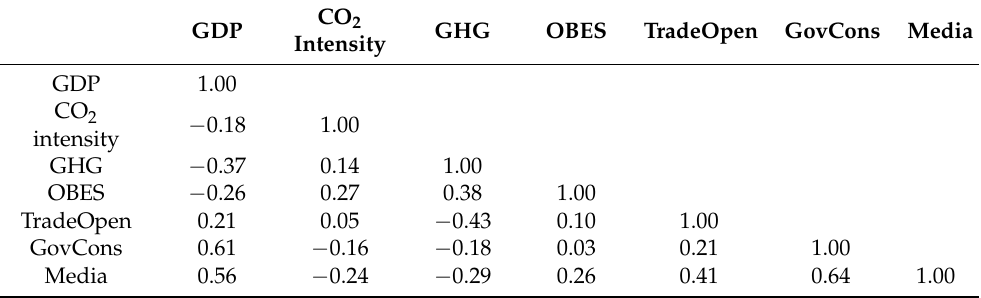
Table 4. The correlogram of the variables.